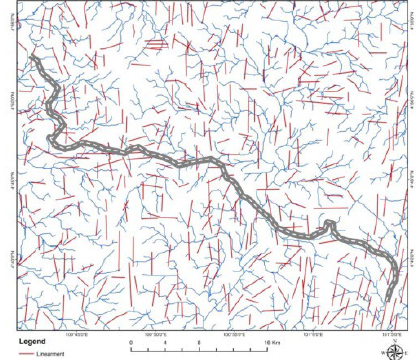
Figure 11: Overlay of lineament map on drainage map with position of Highway